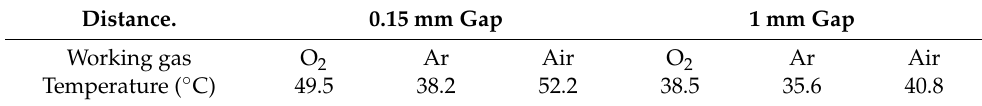
Table 2. The maximum measured temperature of the wood sample surface.